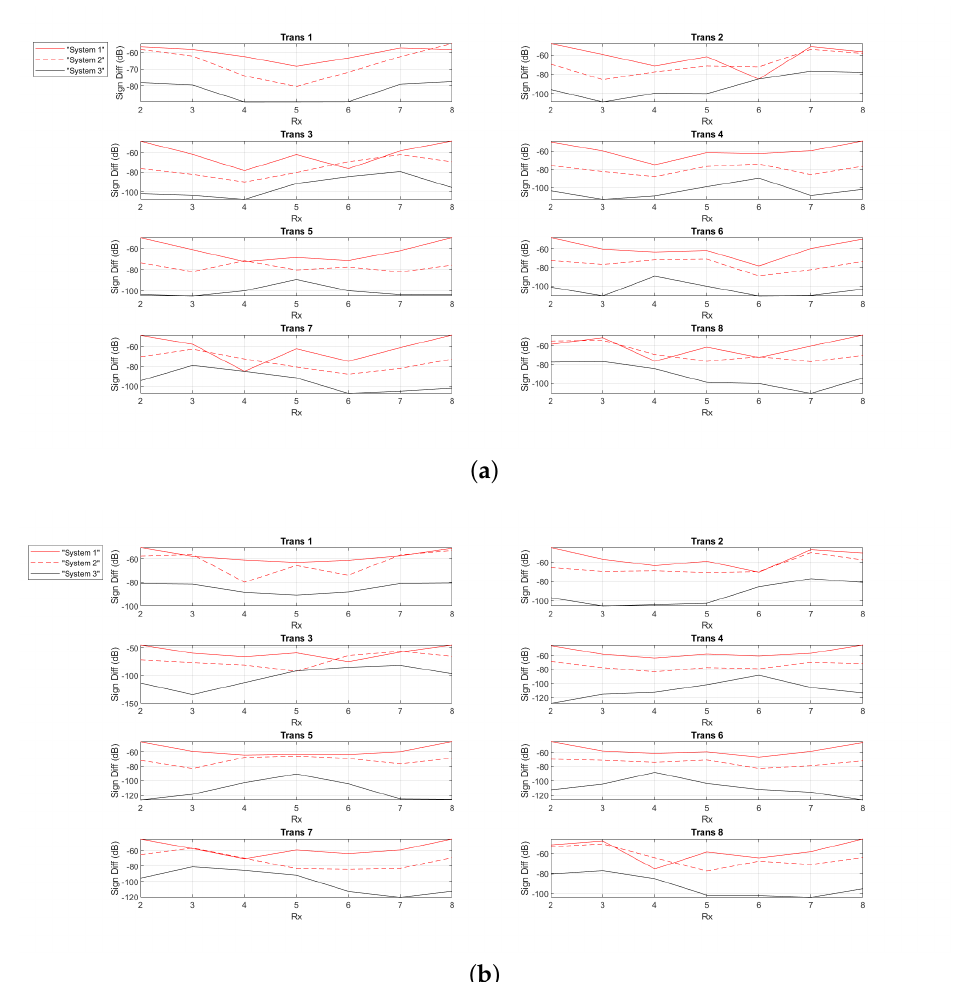
Figure 13. Calculated signal difference “with target - no target” (dB) for the 8-spear patch antenna array operating in infinite matching medium (“System 1”), the 8-PSMA array (“System 2”) and the 8-MTS-enhanced PSMA array (“System 3”) at ( a ) 1 GHz and ( b ) 1.1